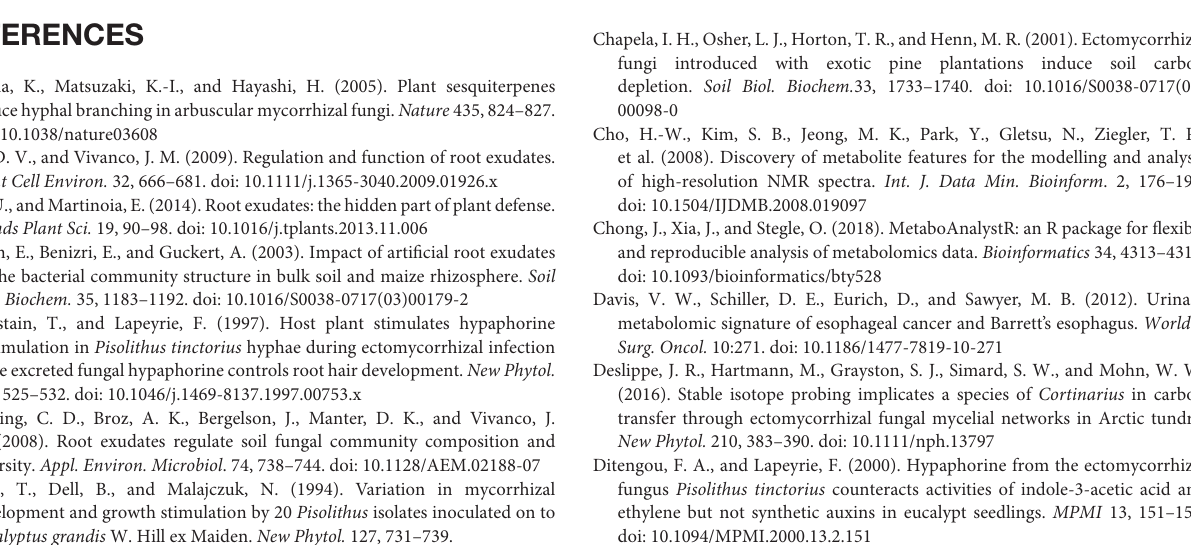
mapped onto the pathway. The color of the boxes represents the log 2 (fold change) value of the gene. Supplementary Figure 11 | Pathway graph to visualize the genes associated with the diterpenoid biosynthesis pathway and their expressions in E. grandis roots during direct physical interaction (coloration on left-hand side of each enzyme box) and pre-symbiotic interaction (coloration on the right-hand side of each enzyme box) with Pisolithus microcarpus in comparison to uninfected control roots. The Arabidopsis thaliana homologs of the E. grandis genes and their expression were mapped onto the pathway. The color of the boxes represents the log 2 (fold change) value of the gene. Supplementary Figure 12 | Pathway graph to visualize the genes associated with the flavonoid biosynthesis pathway and their expressions in E. grandis roots during direct physical interaction (coloration on left-hand side of each enzyme box) and pre-symbiotic interaction (coloration on the right-hand side of each enzyme box) with Pisolithus microcarpus in comparison to uninfected control roots. The Arabidopsis thaliana homologs of the E. grandis genes and their expression were mapped onto the pathway. The color of the boxes represents the log 2 (fold change) value of the gene. Supplementary Table 1 | Raw Metabolite Data Matrix Used for Analyses. Data matrix of the normalized metabolite responses of samples used in this study and the details of the detected molecular features (neutral mass, retention time and composite spectra). The metabolite responses are normalized by the internal standard and sample weight. Supplementary Table 2 | Meta data for samples used for analyses. Supplementary Table 3 | Full list of metabolites specific to microbial lifestyles. Details of detected molecular features (neutral mass and retention time) and their